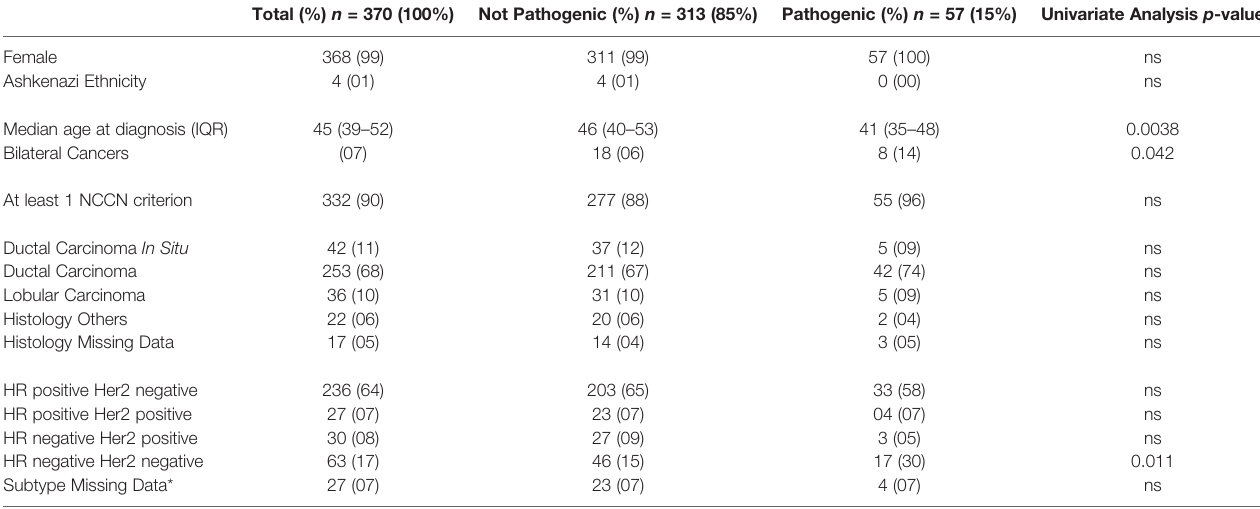
TABLE 1 | Personal characteristics of the study population.